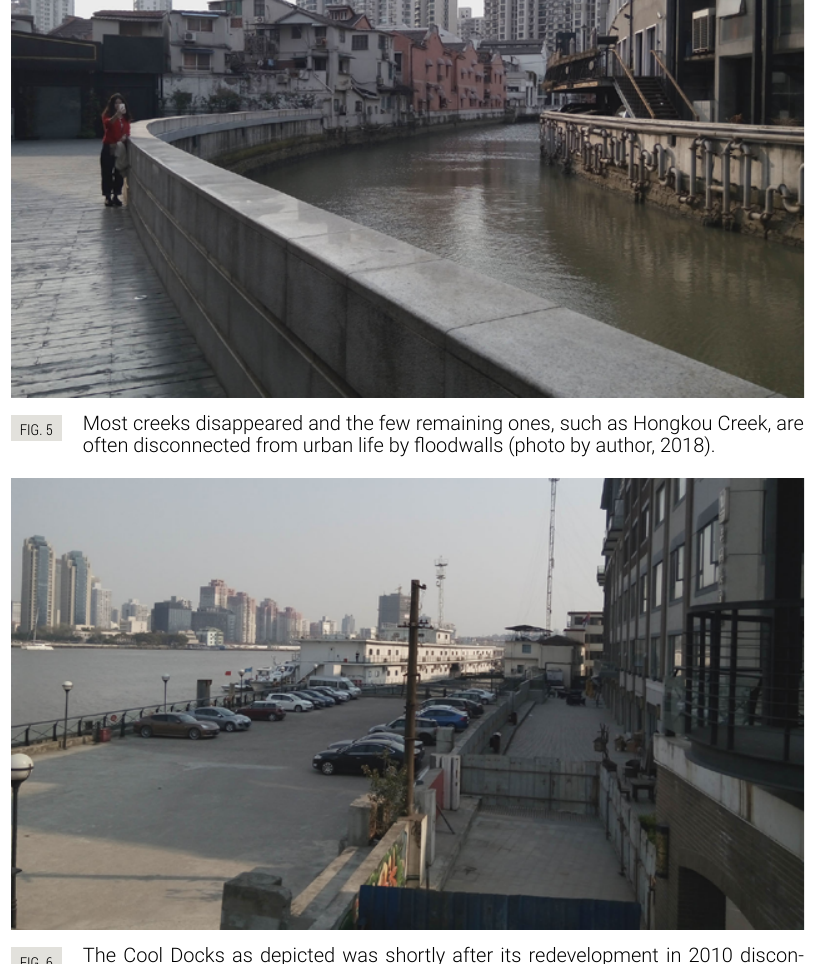
The Cool Docks as depicted was shortly after its redevelopment in 2010 discon- nected from the city by new floodwalls and parking, resulting in the closure of many restaurants in the old warehouses. Since 2018 this area is under redevelopment again (photo by author, 2018).